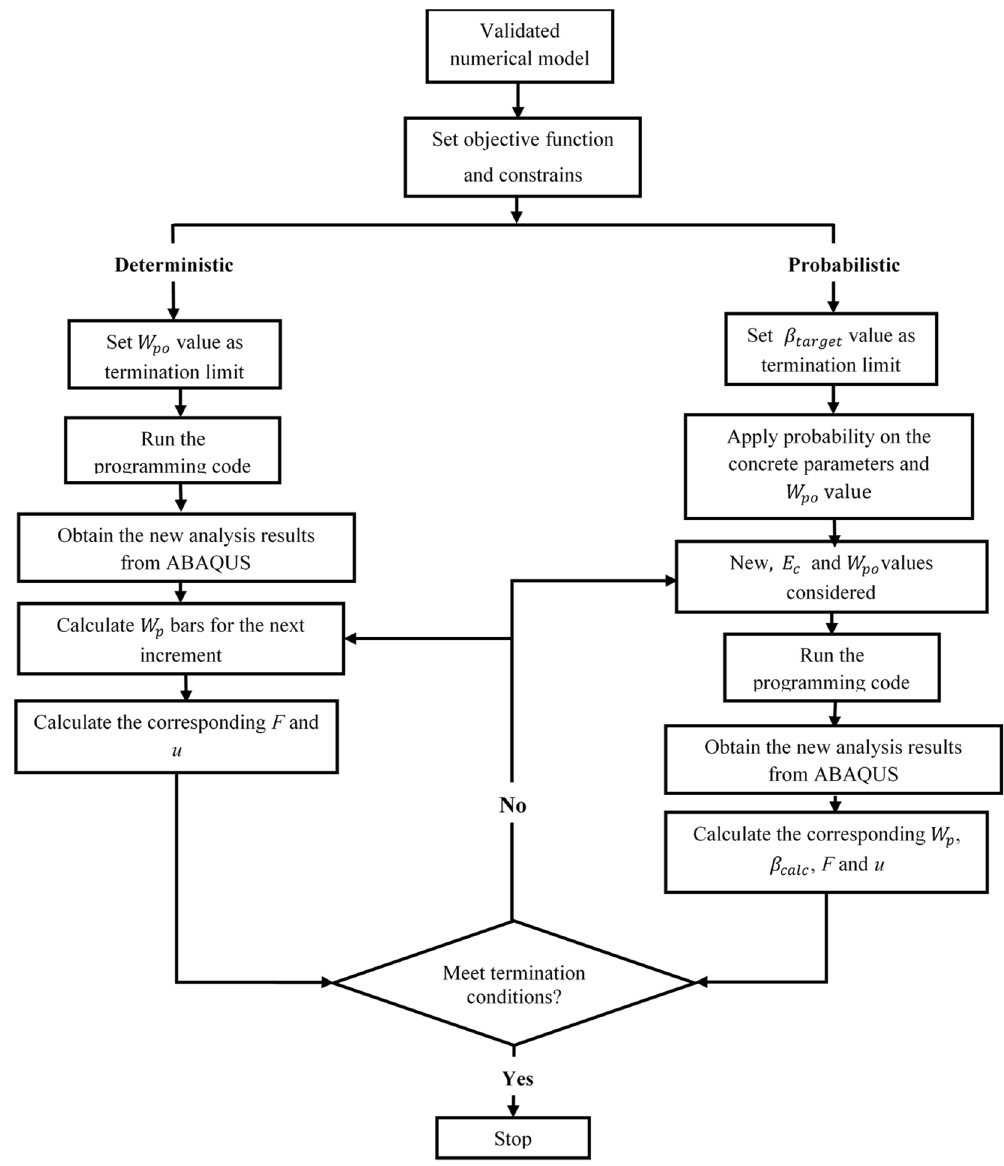
Figure 1. The method to resolving the optimization problem.